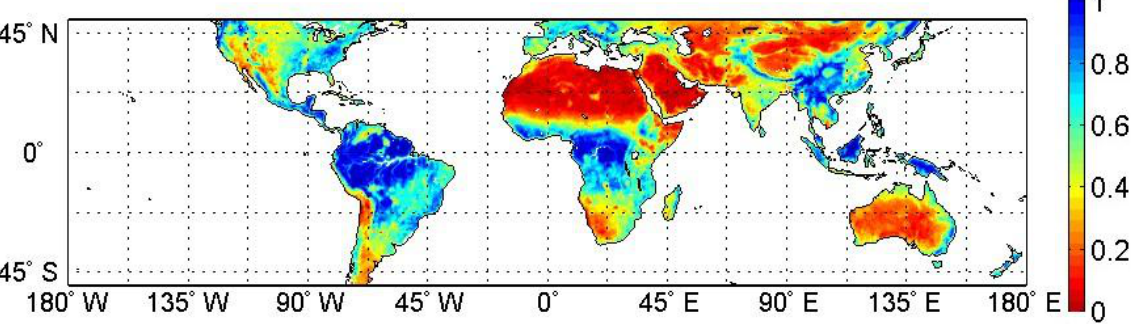
Fig. 2. Average vegetation optical depth ( τ) for the AMSR-E descending overpass retrieved in the period February 2003 till December 2010. Red areas indicate low optical depth values and blue areas indicate high optical depth values.